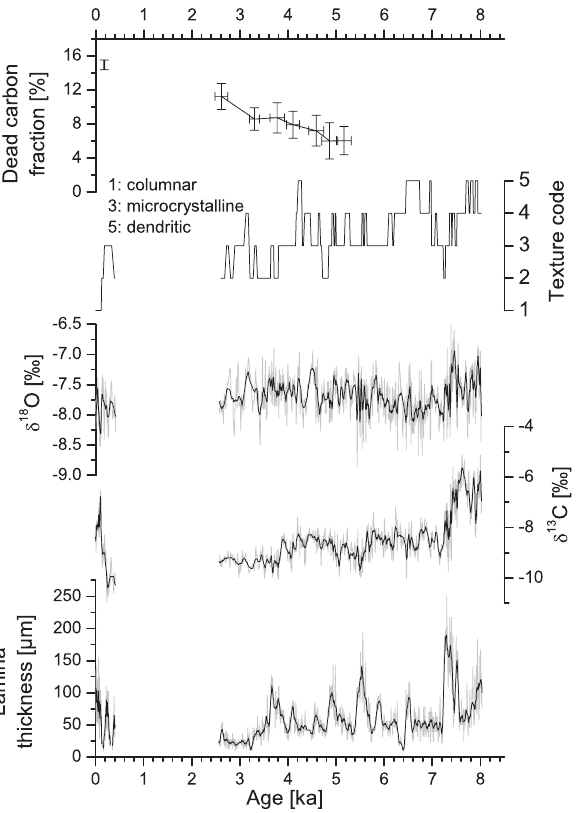
Fig. 4. Lomb-Scargle spectra of the δ 18 O (upper panel) and δ 13 C (lower panel) records of ER 76. The straight curves are the cor- responding 90%, 95% and 99%-false-alarm levels indicating the statistical significance of the individual peaks. The 6-dB bandwidth, determining the frequency resolution, is 0.00044a − 1